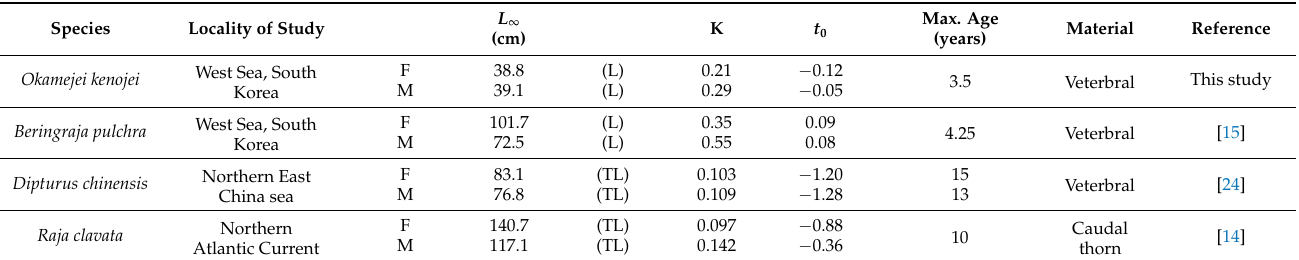
Table 4. Comparison of growth parameters and growth performance indexes among different studies estimated by the von Bertalanffy growth